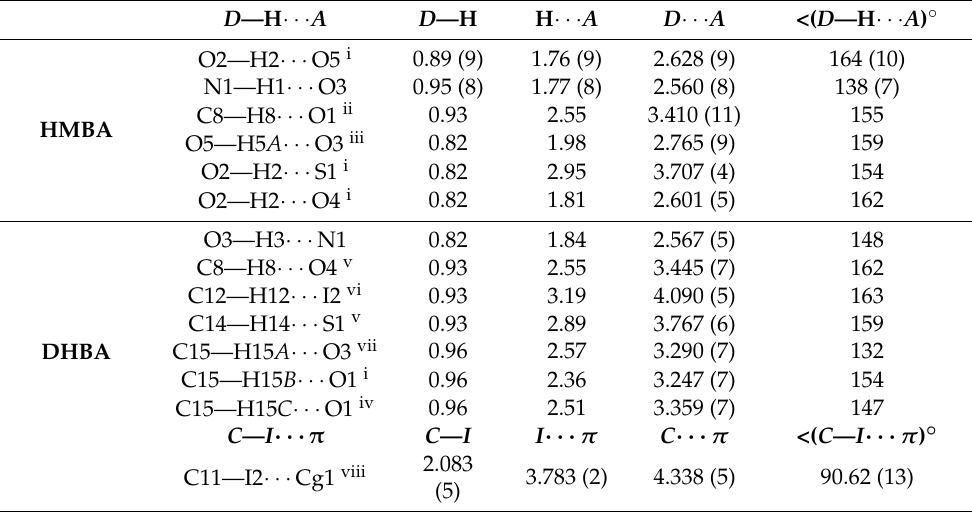
Figure 2. Packing diagram of HMBA showing intra and as well as intermolecular H-bonding. Selected H-atoms are represented for simplicity. Table 1. Hydrogen-bond geometry (Å, ◦ ) for HMBA and DHBA with C—I ··· π interaction for DHBA